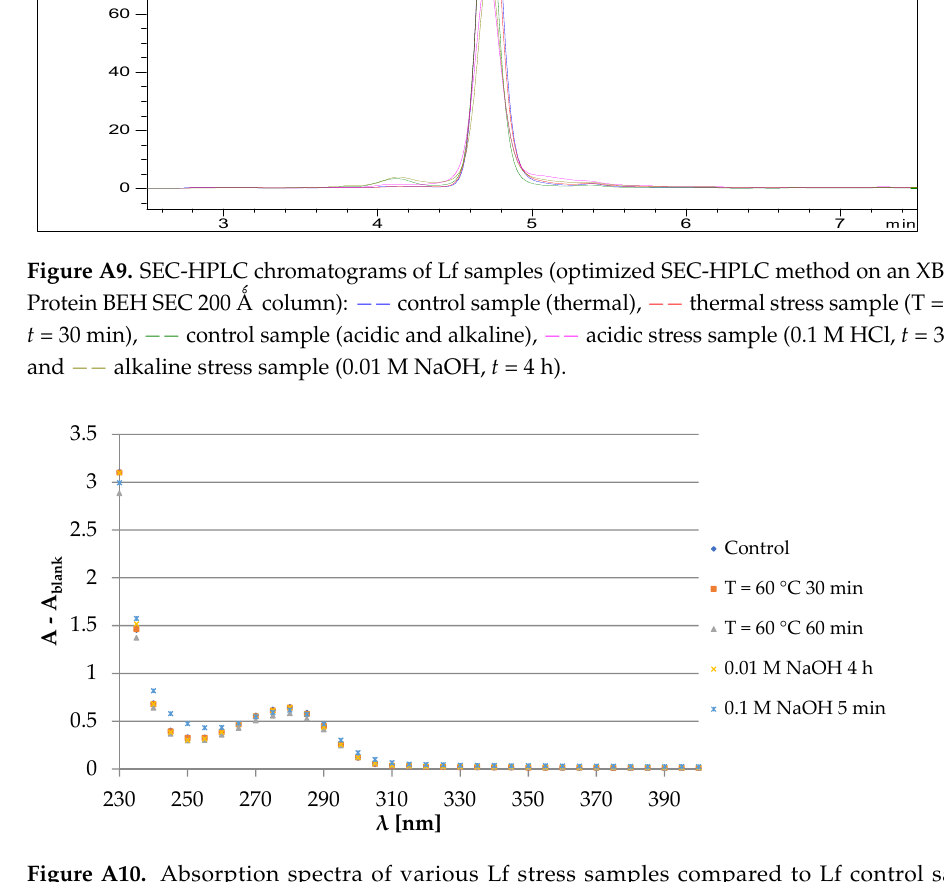
Figure A10. Absorption spectra of various Lf stress samples compared to Lf control sample (A 280 nm method).